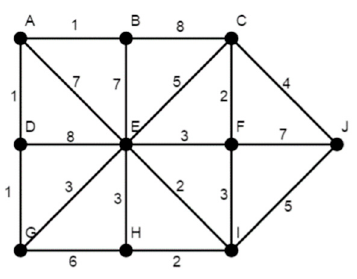
Figure A2. Scheme to problem 2.